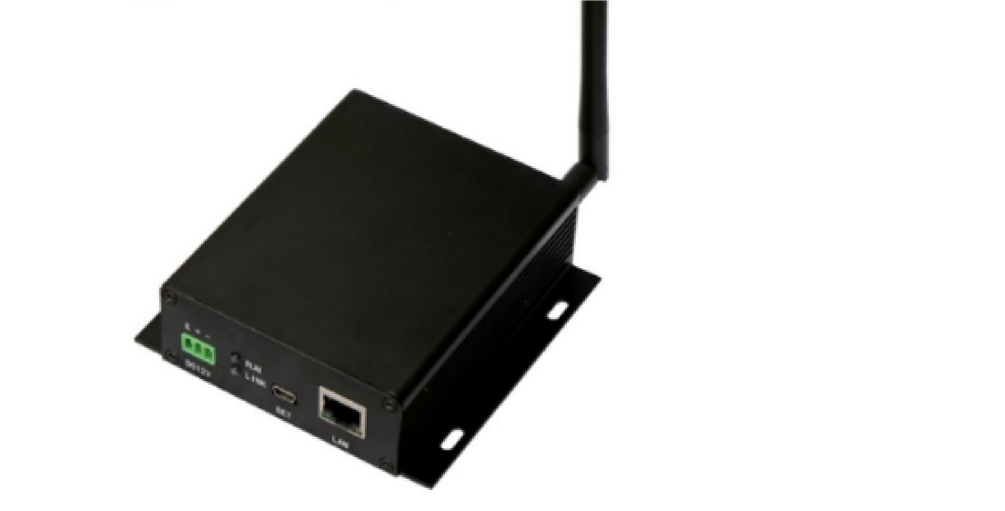
Figure 7. Electronic tag network card reader.